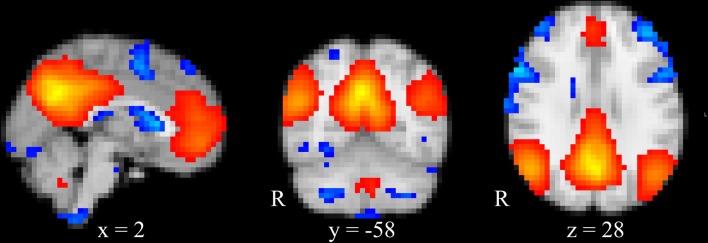
Group ICA estimated DMN. DMN obtained from temporally concatenated group ICA. Images are superimposed onto the MNI standard brain. Blue indicates z-scores below the 10th percentile and red indicates z-scores above the 90th percentile.